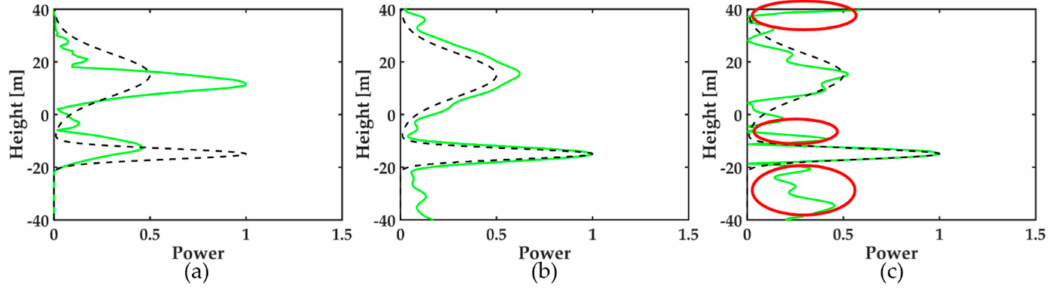
Figure 3. The reconstructed reflectivity profiles by the W&O-compressive sensing (CS) TomoSAR method for a simulated signal (r > 1) with di ff erent hyperparameters: ( a ) 100; ( b ) 1000; ( c )